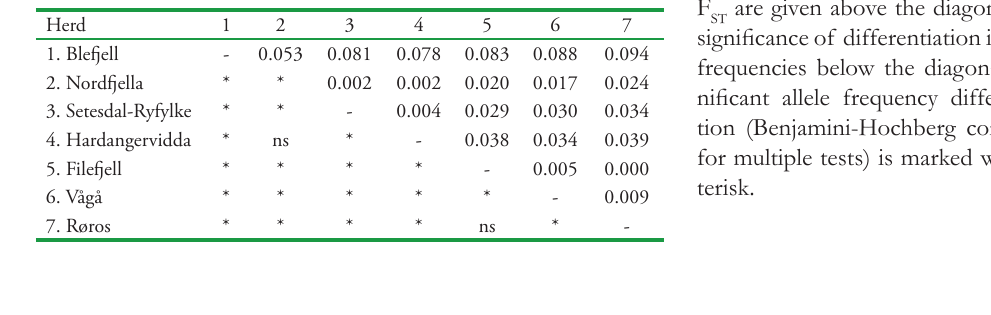
Table 8. Genetic differentiation among reindeer herds across 14 microsatellite loci. Pair wise values of